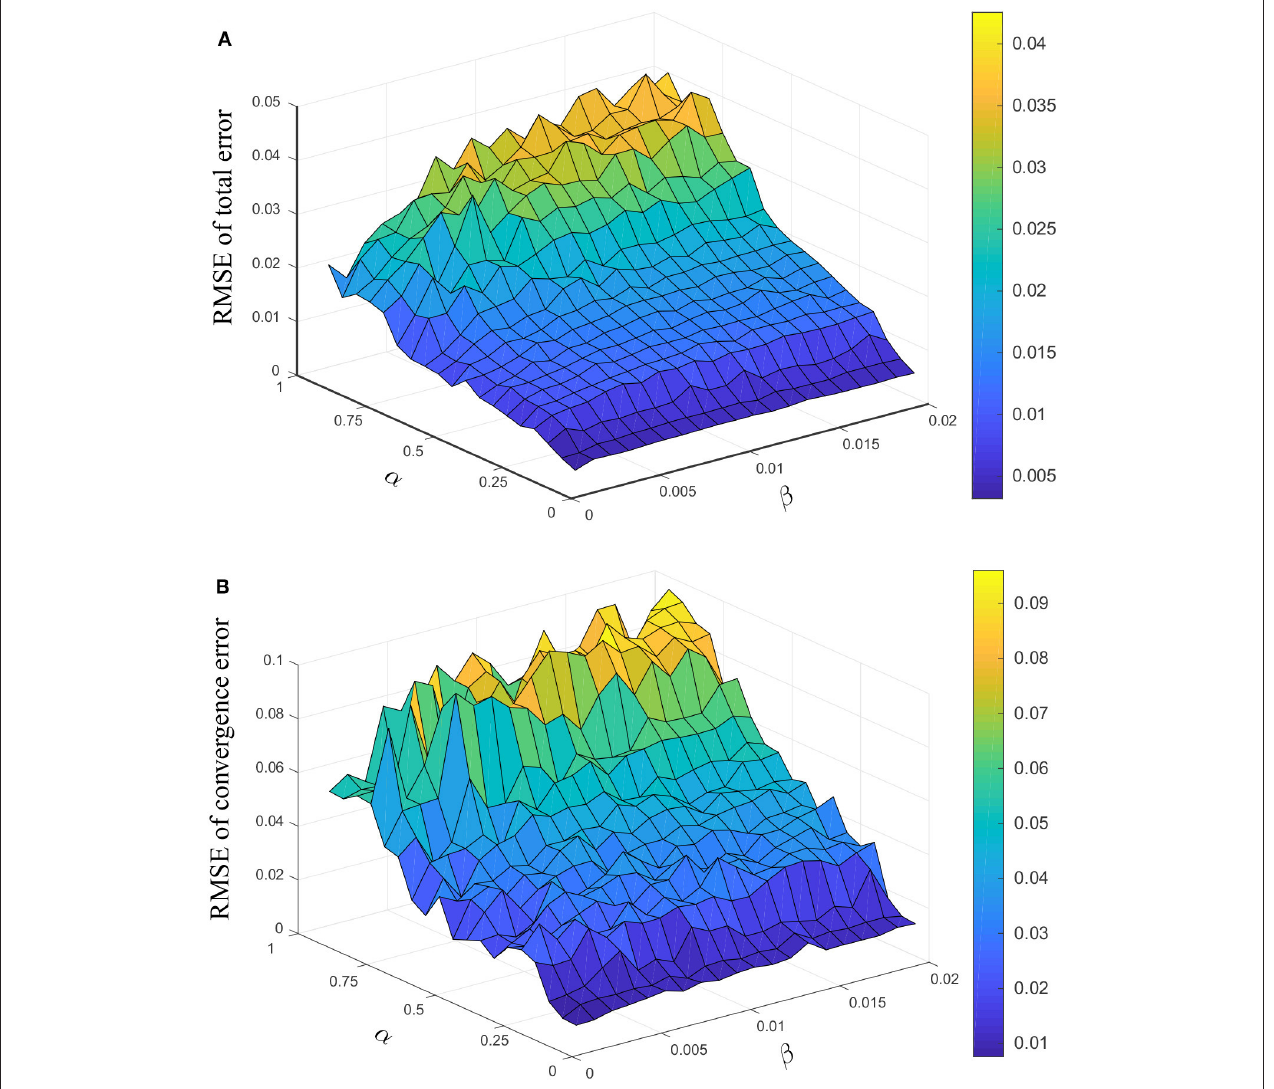
FIGURE 7 | Root mean square error (RMSE) of VSEKF considering different parameters α and β , (A) RMSE of total error of the estimation, (B) RMSE of convergence error in the first 3 s.